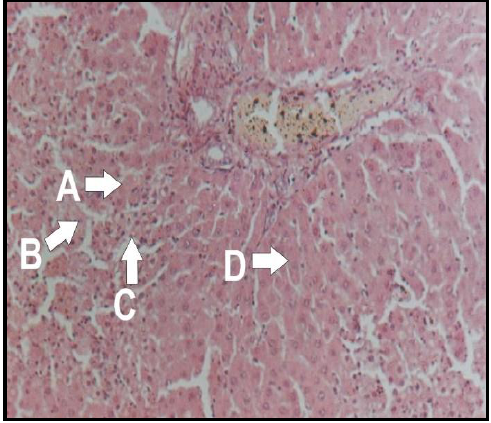
Figure (4): Section of rat's liver showing the effect of pre-treatment with 50mg.kg - 1 .day 1 PTX for 14 days prior to CCl -A: Necrotic damage. -B: Inflammatory cell infilteration -C: Kupffer cell no hyperplasia. -D: Normal hepatocyte. Magnification: (10*10); staining: Haematoxylline and